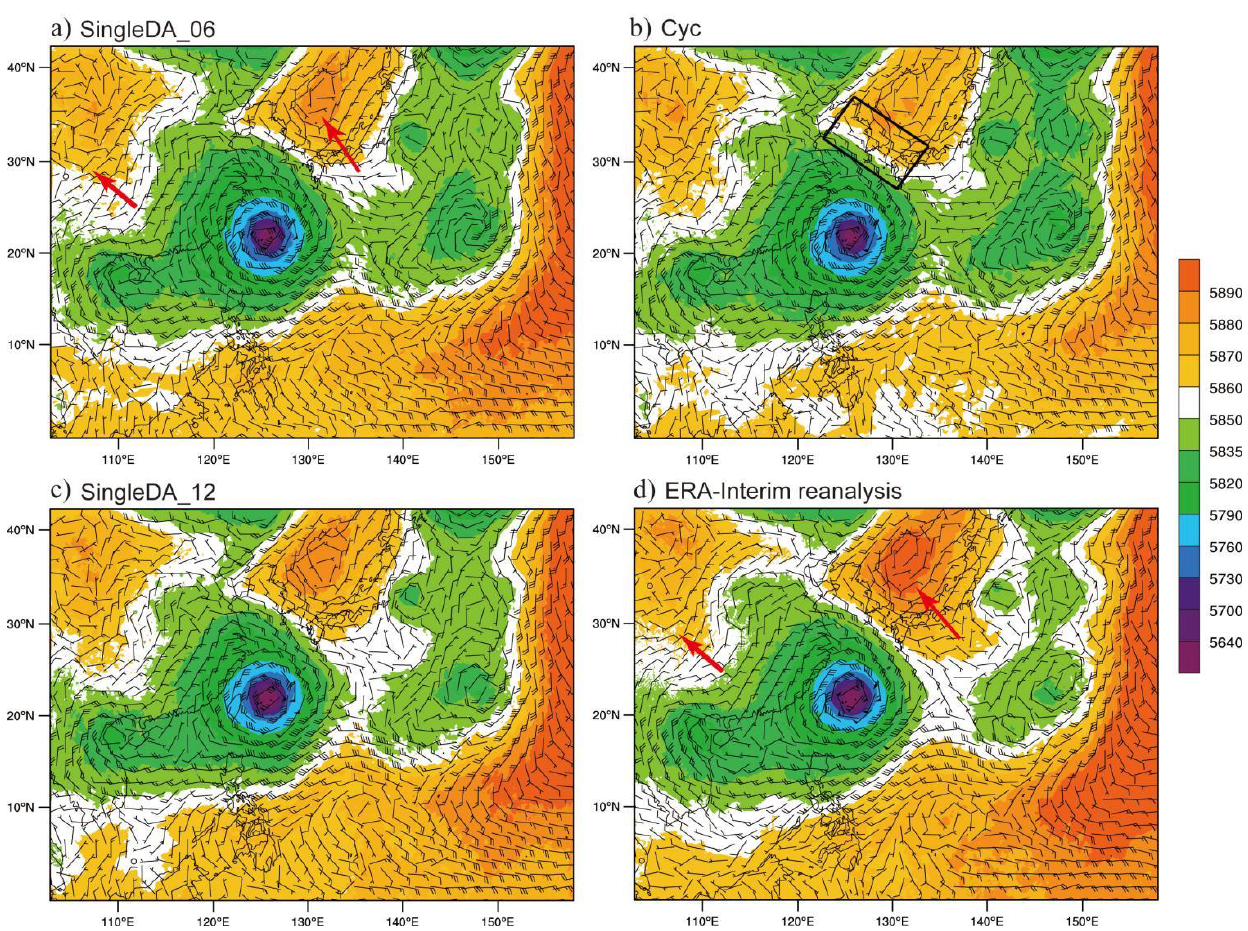
Figure 8. The 500 hPa geopotential height (shaded, units: gpm) and wind field (wind shaft, units: m/s) from the ( a ) SingleDA_06, ( b ) Cyc, ( c ) SingleDA_12 experiments, and ( d ) corresponding ERA- Interim reanalysis fields valid at 1200 UTC 23 July 2021.